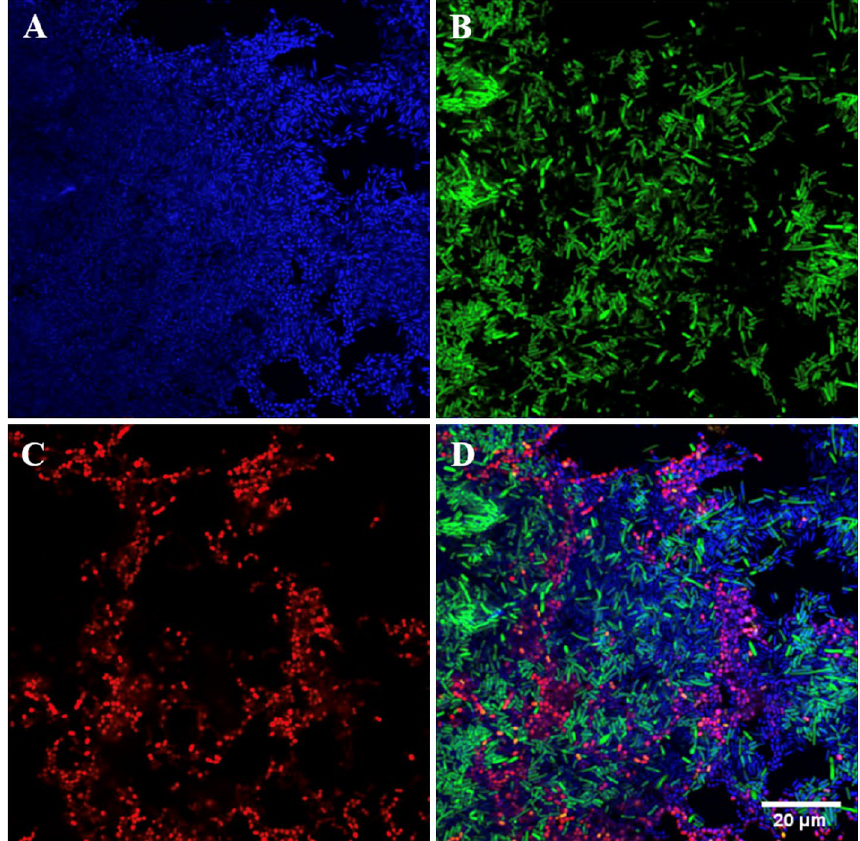
Figure 2. Fluorescence in situ hybridisation staining of Streptococcus pyogenes ATCC 700,294 and Escherichia coli K-12 DH5 alpha, ATCC PTA-4079 mixed cells from broth culture. ( A ) Nucleic material/DAPI in blue, ( B ) Eubacterial probe (EUB) in green, ( C ) Streptococcus spp . specific probe (STRC493) in red, ( D ) composite image of ( A – C ). Images at ×60